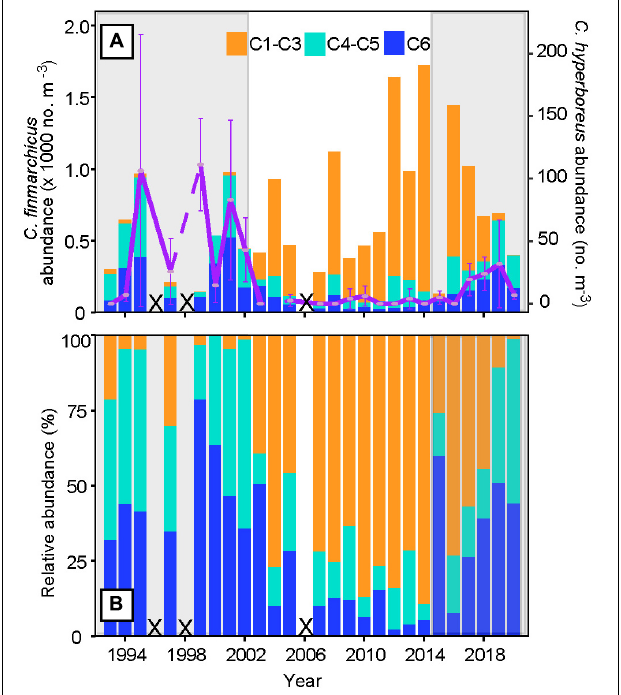
FIGURE 2 | Stage composition of Calanus finmarchicus and mean abundance of Calanus hyperboreus within the subarctic region at Section N [ (A) , blue line in Figure 1 ] and [ (B) relative abundance of C. finmarchicus , from 1993 to 2020]. The developmental stages of C. finmarchicus are grouped into recruits (C1–C3, orange), juveniles (C4–C5, light blue), and adults (C6, dark blue), while the mean abundance of all C. hyperboreus stages is shown in purple, together with the 95% confidence interval. The periods from 1993–2002 and 2015 to 2020 are highlighted in gray to illustrate co-occurring increased influx of arctic water into the southwestern Norwegian Sea (Skagseth et al., in review). Years with missing data are marked with